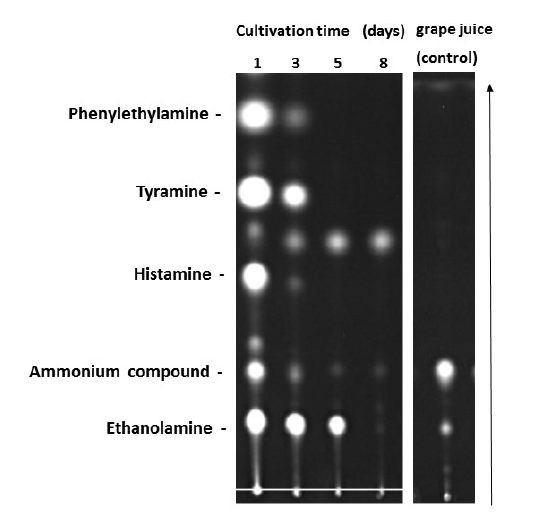
Figure 3. Kinetics of BA degradation by D. hansenii H525 as detected by TLC. Cultivation in red grape juice with 0.25 mM of each amine. The spots in the non-treated grape juice correspond to an intrinsic ammonium compound and to ethanolamine. The arrow indicates direction of separation.